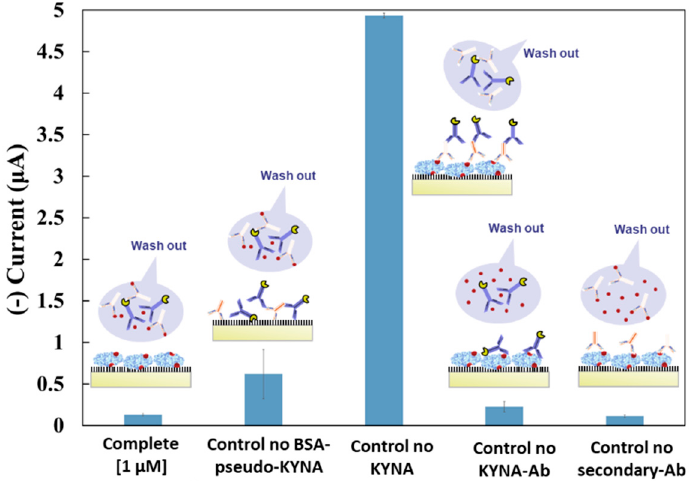
Figure 3. KYNA immunosensor selectivity test characterized with CA. A scheme of the results represents the possible molecules on the sensor surface and washed out after incubation.